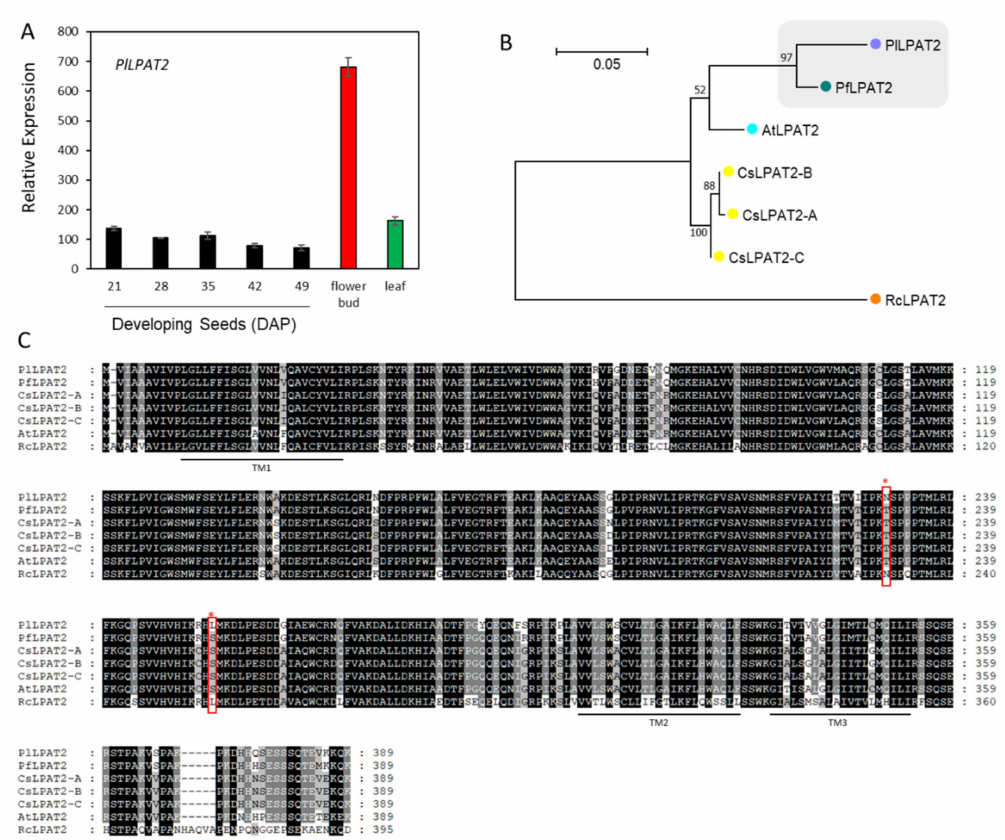
Figure 8. Characterization of LPAT2 proteins. ( A ) Relative expression level of PlLPAT2 in the developing seed, flower, and leaf tissue by qRT-PCR. DAP; day after pollination. ( B ) Phylogenetic tree of LPAT2s in various species. Pl, Physaria lindheimeri ; Pf, Physaria fendleri ; At, Arabidopsis thaliana ; Cs, Camelina sativa ; Rc, Ricinus communis . PlLPAT2 and PfLPAT2 are highlighted with a grey background. ( C ) Amino acid alignment of LPAT2 protein sequences. Putative transmembrane domains are underlined. The 230th and 255th amino acids of PlLPAT2 are indicated by red asterisks and boxes. Genbank accession numbers are listed in Supplementary File 6, Table